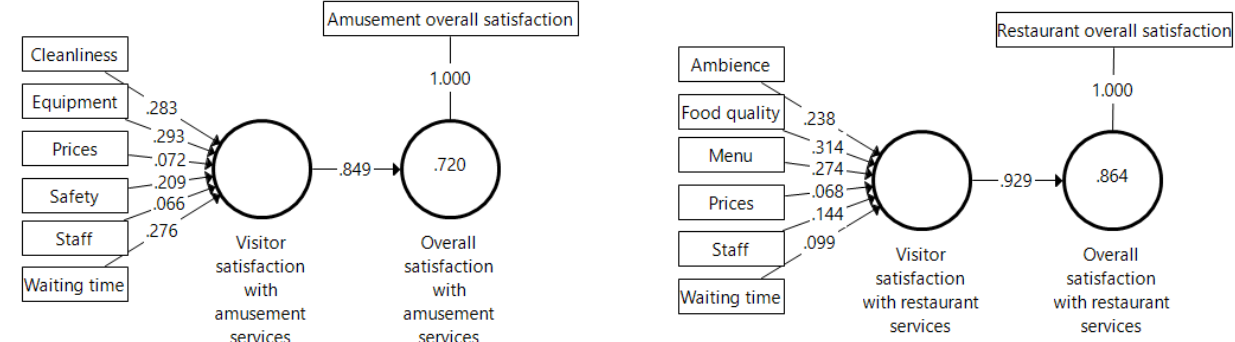
Figure 2. Redundancy analysis for assessing the convergent validity of formative variables. Note: Outer weights and path coefficients on arrows, R 2 values in circles.